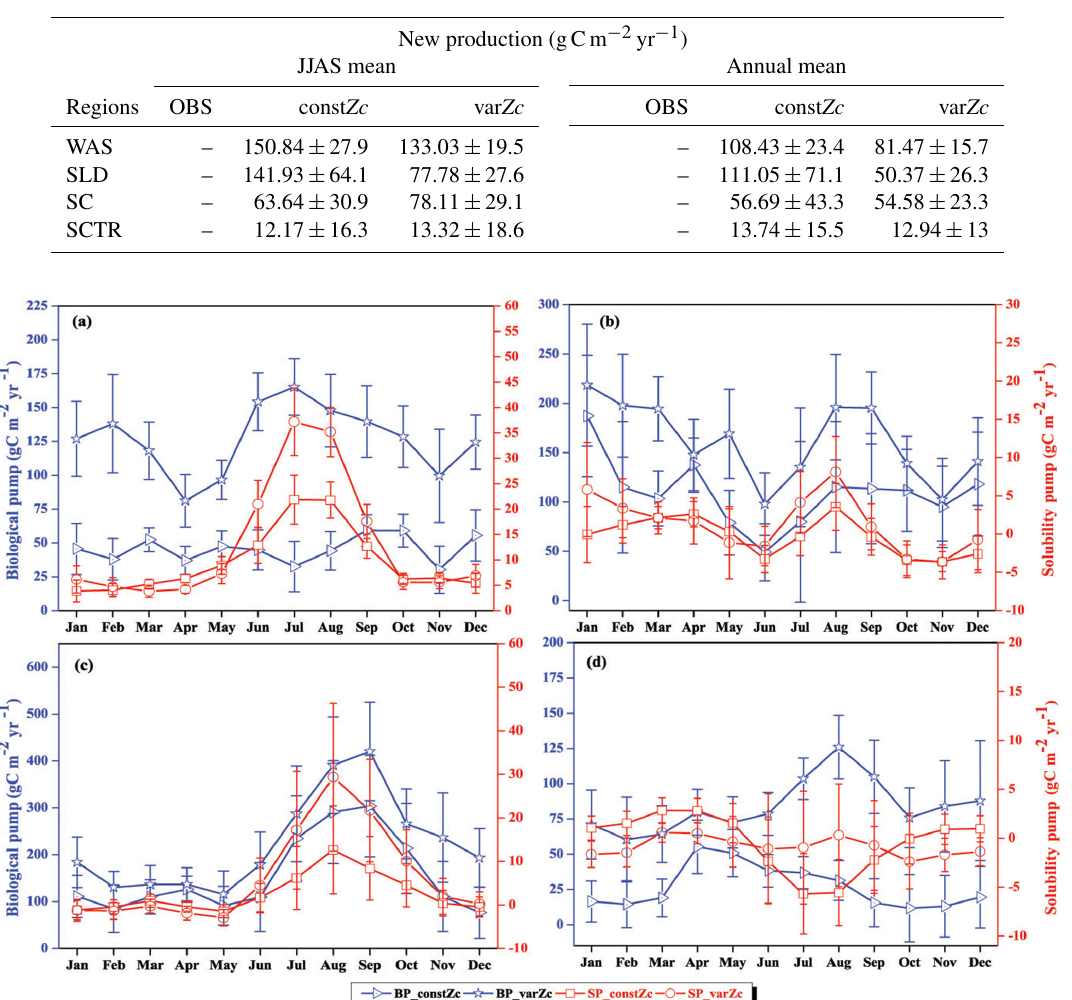
Table 4. Model-derived values for new production. Units are gCm − 2 yr − 1 .